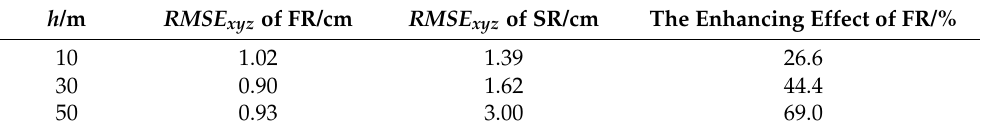
Figure 7. 3D model of concrete beam: ( a ) the model of FR; ( b ) the model of SR. Table 3. The effect of different routes on reconstructed quality of the 3D beam model.